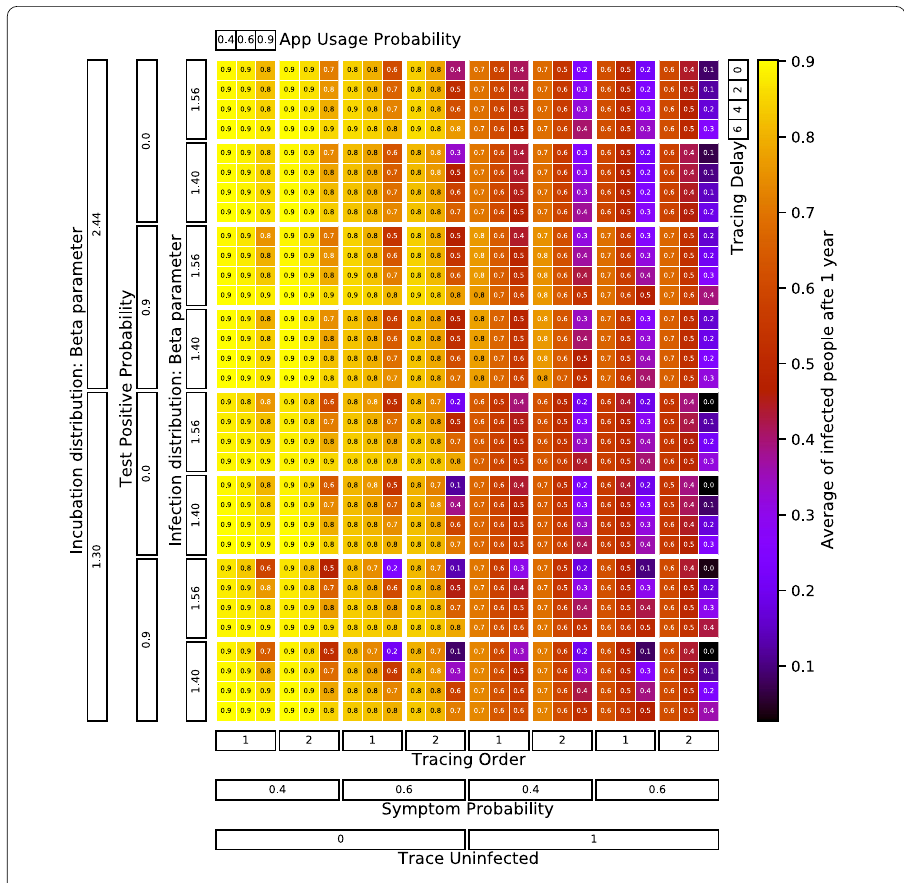
Figure 32 The total fraction of the population that has been exposed one year into the outbreak is shown for all combinations of parameters in the timing and delay parameter